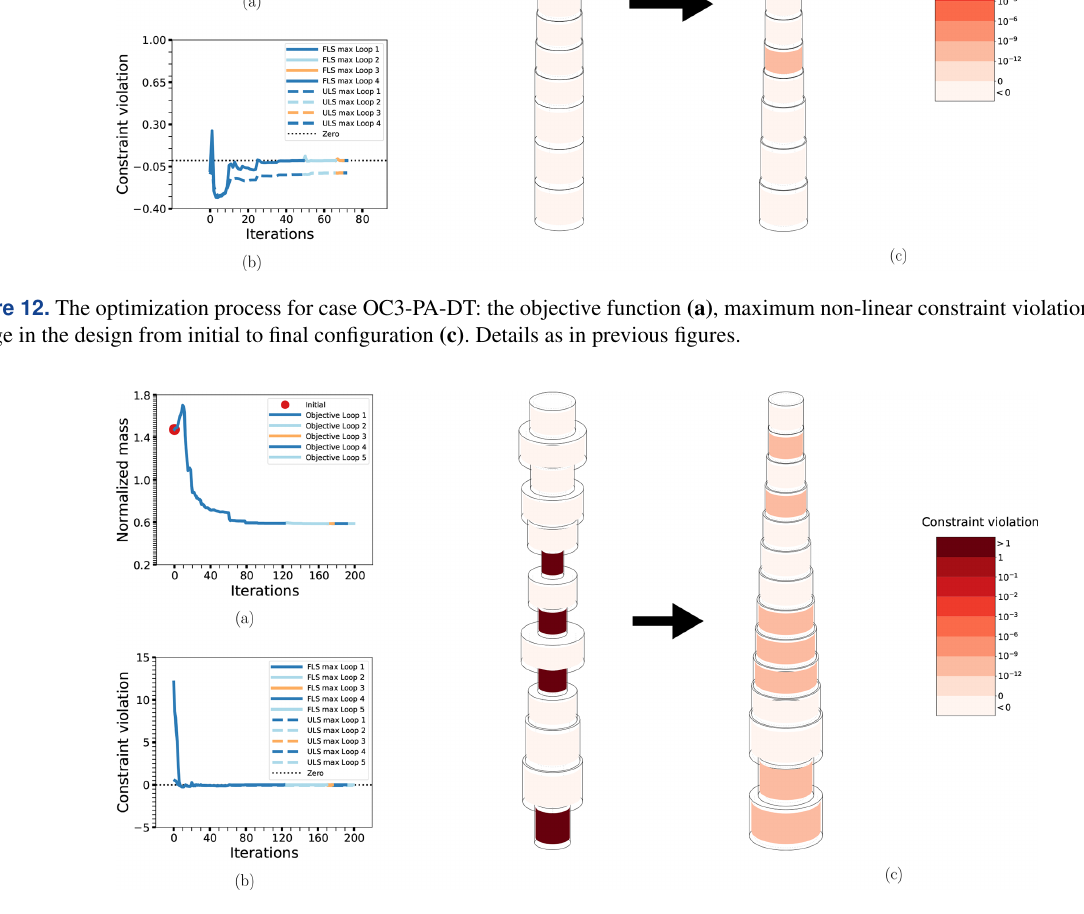
Figure 13. The optimization process for case OC3-PA-RND: the objective function (a) , maximum non-linear constraint violations (b) and the change in the design from initial to final configuration (c) . Details as in previous